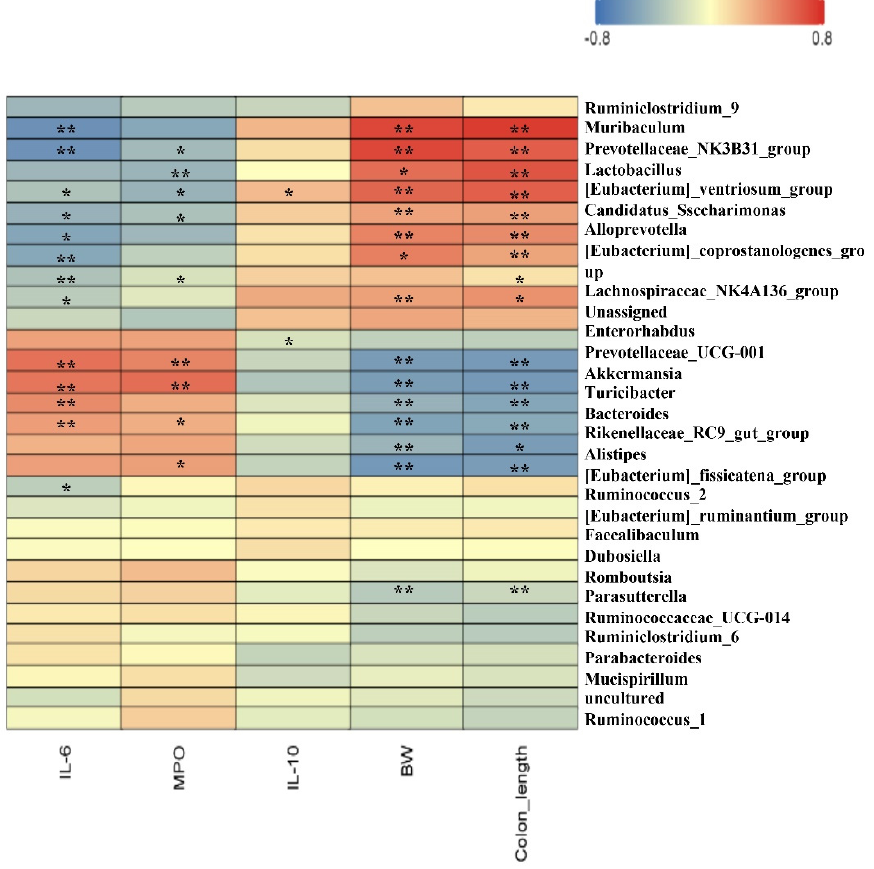
Figure 6. Spearman correlation between gut top 30 genera and growth development or serum biochemical parameters. The red color denotes a positive correlation, whereas the blue color denotes a negative correlation. The intensity of the color is proportional to the strength of the Spearman correlation. Data are mean ± SEM, n = 6/group. *, ** indicate a significant different. DSS, dextran sulfate sodium; MPO, myeloperoxidase; BW, body weight.